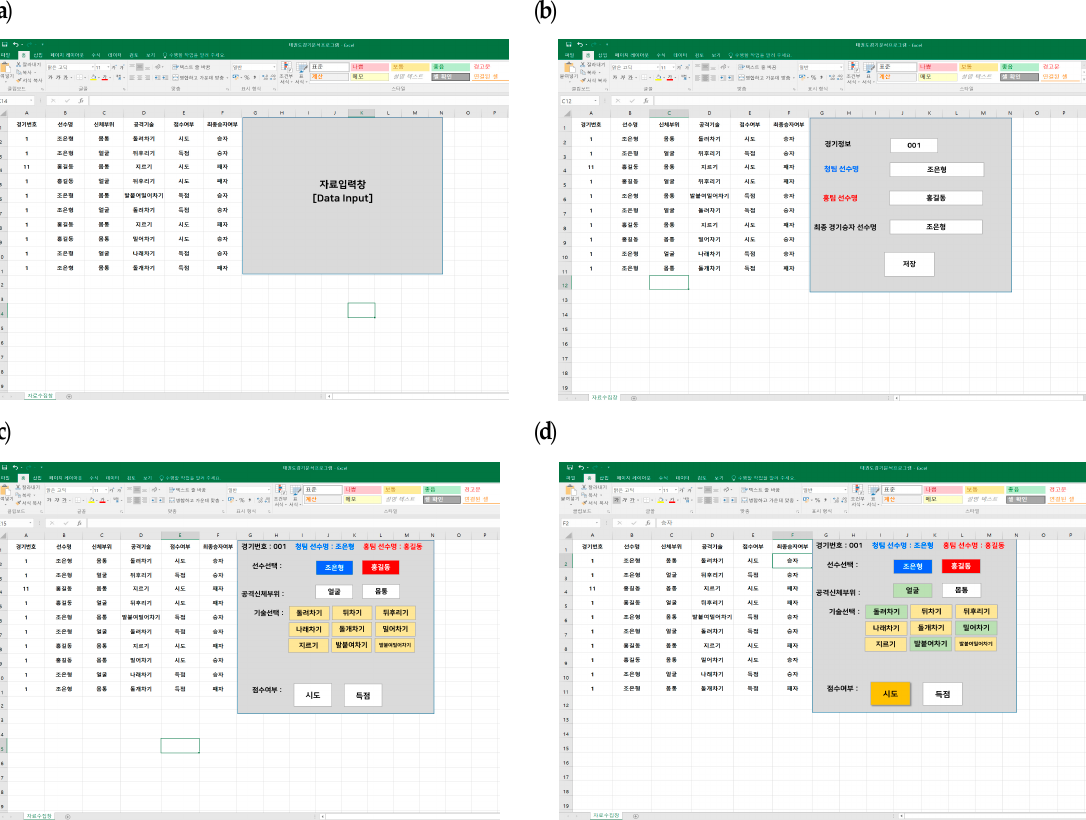
Figure 1. Data input program for Taekwondo. ( a ) Match Information; ( b ) Player Identification; ( c ) Attack target for the skill execution; ( d ) Outcome of the skill